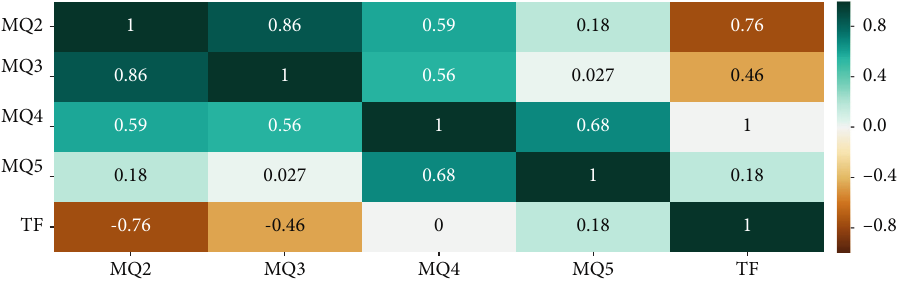
Figure 9: Correlation between the two variables—second peak